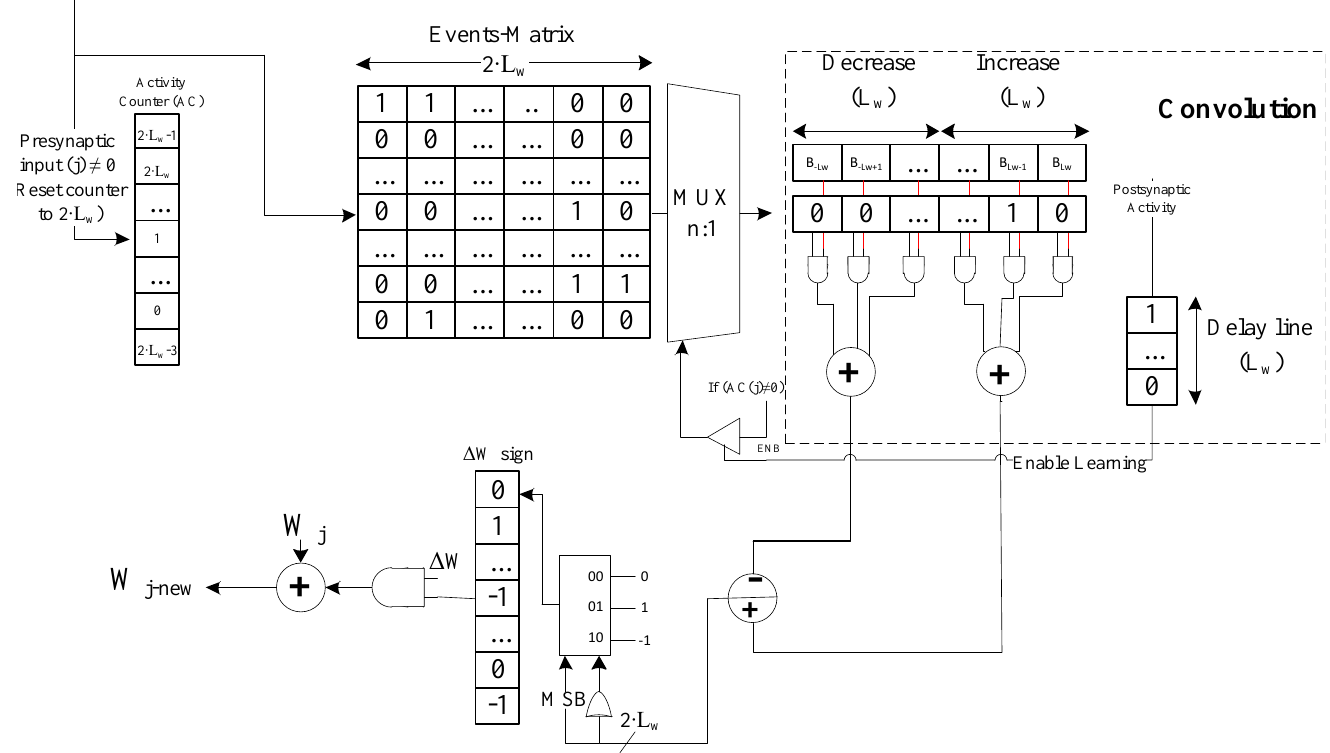
Figure 2. Spike Timing Dependent Plasticity (STDP)-based learning